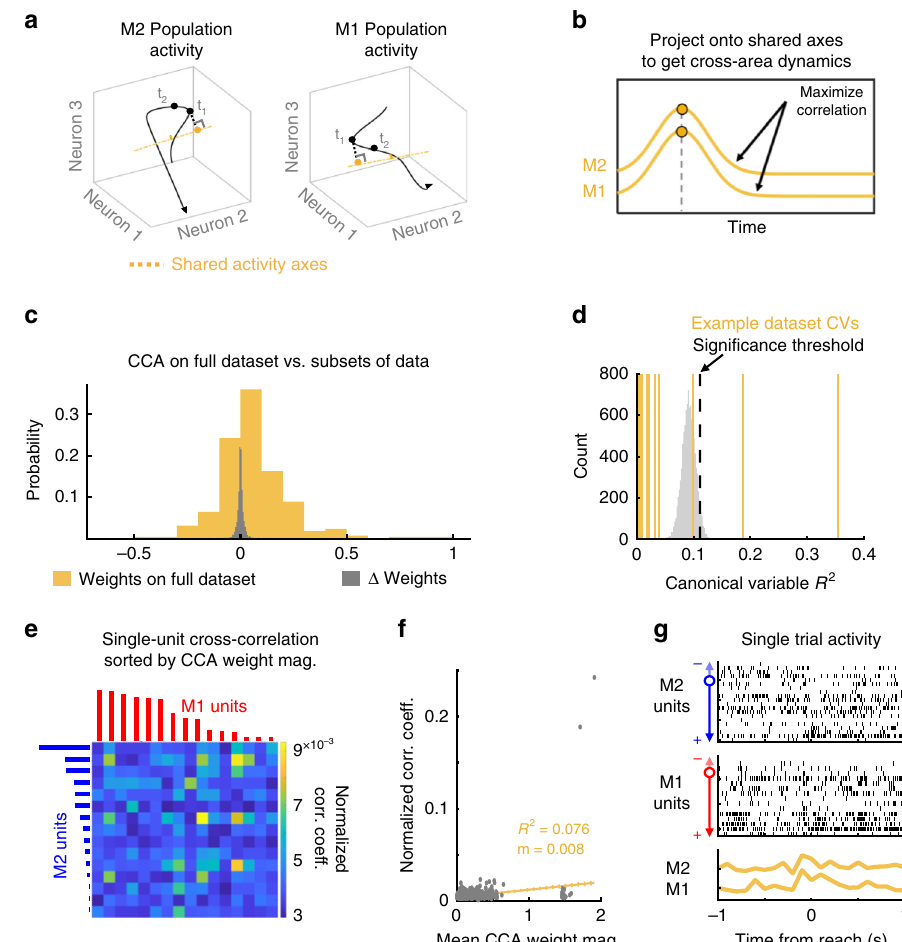
Fig. 2 Canonical Correlation Analysis identi fi es shared cross-area dynamics. a Illustration of method for identifying cross-area dynamics. A multidimensional neural space can be de fi ned using the activity of each M2 (left) or M1 (right) neuron as one dimension. Neural trajectories are shown in black (arti fi cial data). Canonical correlation analysis (CCA, yellow) is used to identify shared axes, such that when the neural trajectories are projected onto these axes, as shown in b , the resulting trajectories, called cross-area dynamics, are maximally correlated between M2 and M1. The yellow dots for M1 and M2 illustrations are the projected values for the same timepoint in a . c In yellow, distribution of CCA weights when fi tting on the full datasets. In gray, distribution of weights differences from ten subsamplings of each dataset (i.e., weight from subset − weight from full dataset). d Example identi fi cation of signi fi cant canonical variables (CVs, yellow lines), relative to trial-shuf fl ed data (gray distribution, 10 4 shuf fl es). Signi fi cance threshold at 95th percentile of reference distribution. For this dataset, two CVs were signi fi cant. e Example comparison of CCA weight magnitude to single-neuron pairwise cross- correlations. M1 units (red) and M2 units (blue) are ordered by the absolute value of their CCA weight for the top CV. Color in the cross-correlogram indicates normalized peak correlation coef fi cient for timelags between − 200 and + 200 ms. f Across animals, pairwise cross-correlation is correlated with mean CCA weight magnitude for that neuron pair. g CCA identi fi es moment-to-moment shared covariation patterns that may be hard to see by eye in single-trial data. (Top) Population raster for an example trial in M2, where each row is a single neuron, sorted by CCA weight. (Middle) Population raster for the same trial in M1, sorted by CCA weight. (Bottom) The M2 and M1 cross-area dynamics for that same trial. The R 2 between the M2 and M1 cross- area dynamics on this example trial is